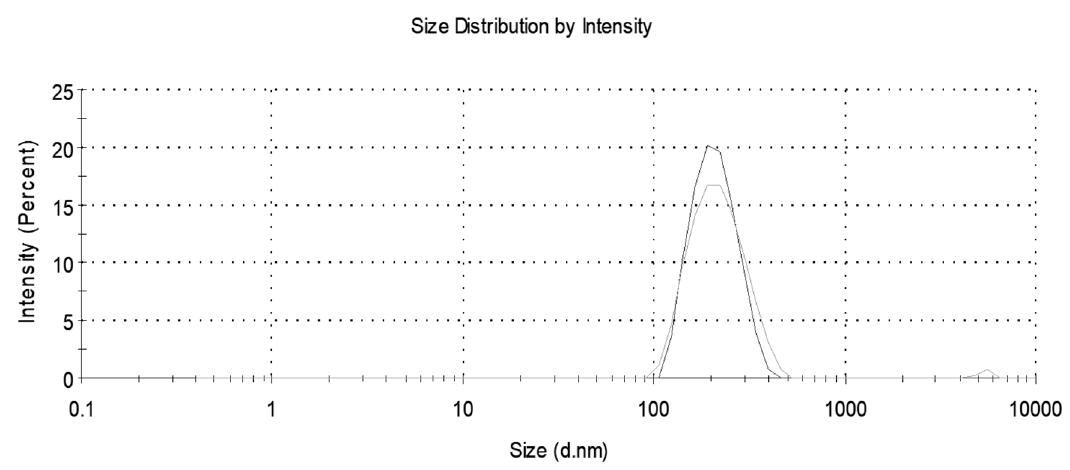
Figure 2. Particle size distribution of nanoplastic particles (Nano ZS Zetasizer). Lines indicate replicate results.